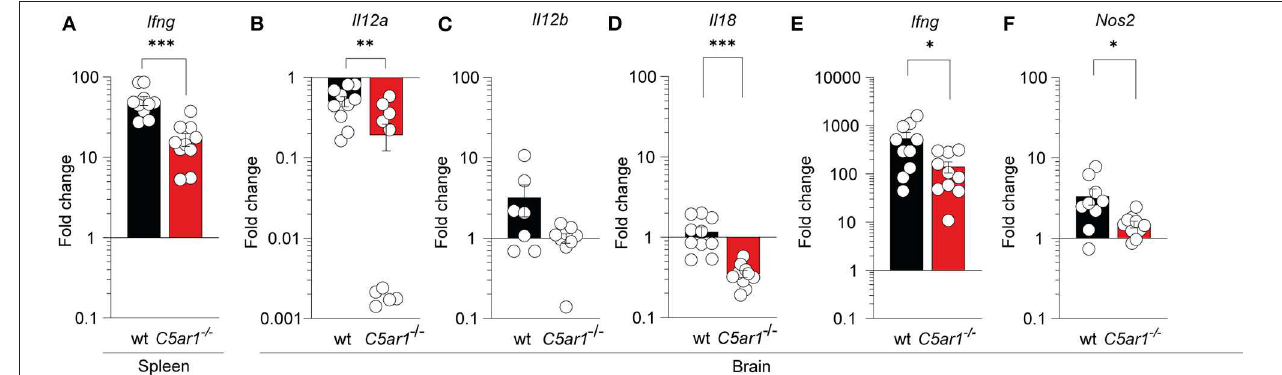
FIGURE 5 | Impact of C5aR1 deficiency on Ifng mRNA expression in the spleen and brain and on Il12a, Il12b, Il18 , and Nos2 mRNA expression in the brain during the early phase of T. gondii infection. Ifng mRNA transcription in the spleen (A) , and Il12a (B) , Il12b (C) , Il18 (D) , Ifng (E) , and Nos2 (F) in the brain of wt and C5ar1 − / − mice 7 days after T. gondii infection as determined by RT-qPCR. The data show the relative change in mRNA transcripts in comparison to uninfected mice; the reference value for uninfected mice was set as 1, n = 10/group. Values shown are the mean ± SEM, Differences between groups were determined by unpaired t -test, * p < 0.05, ** p < 0.01, *** p <